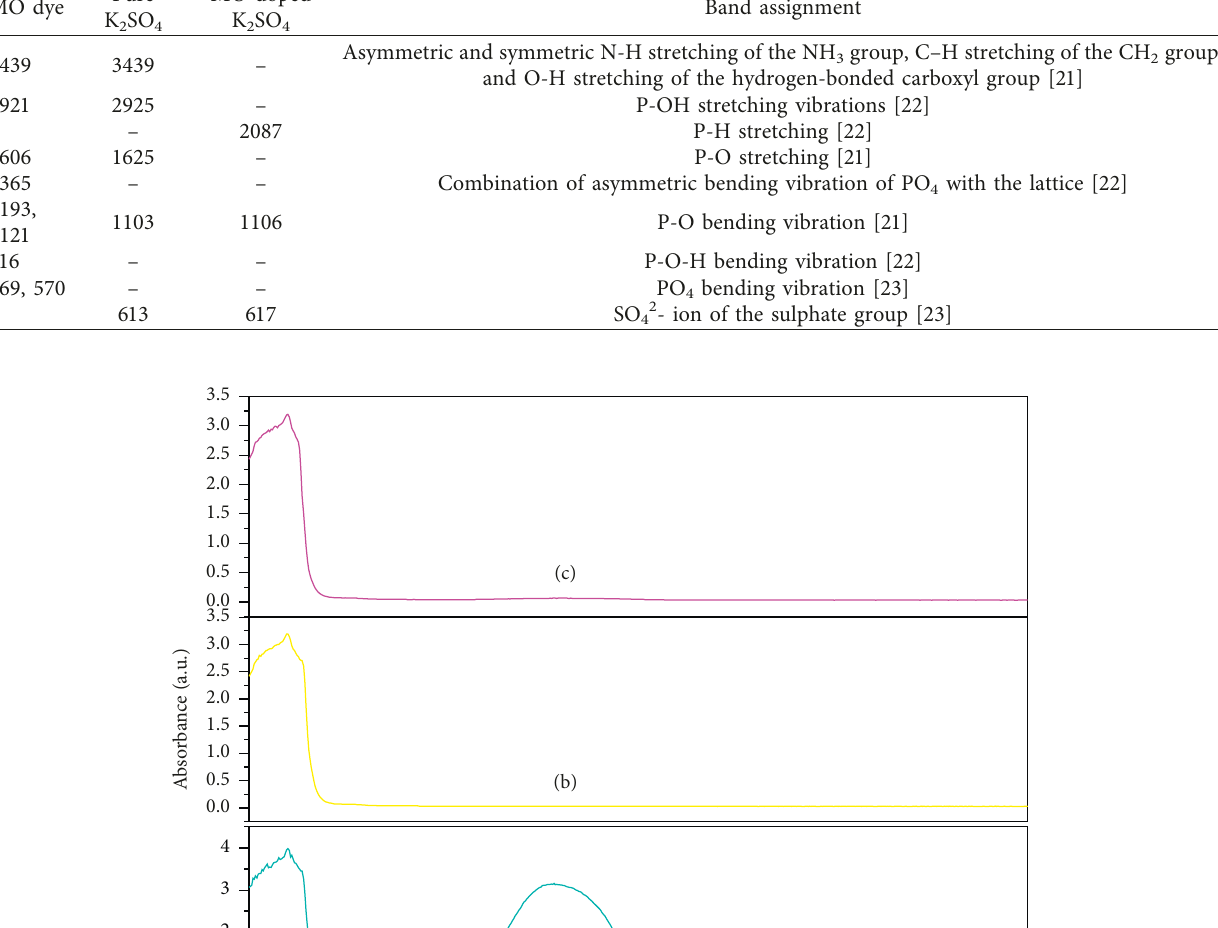
2 SO 4 single crystal.